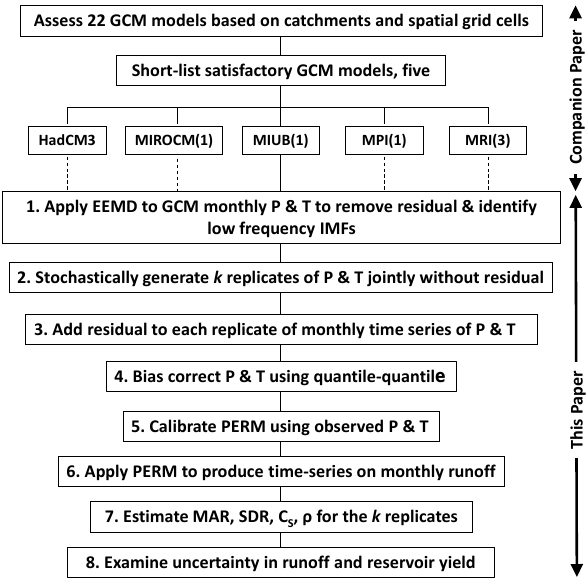
Figure 1. Outline of process to approximate within-GCM uncer- tainty of future runoff and reservoir yield. The companion paper is McMahon et al.